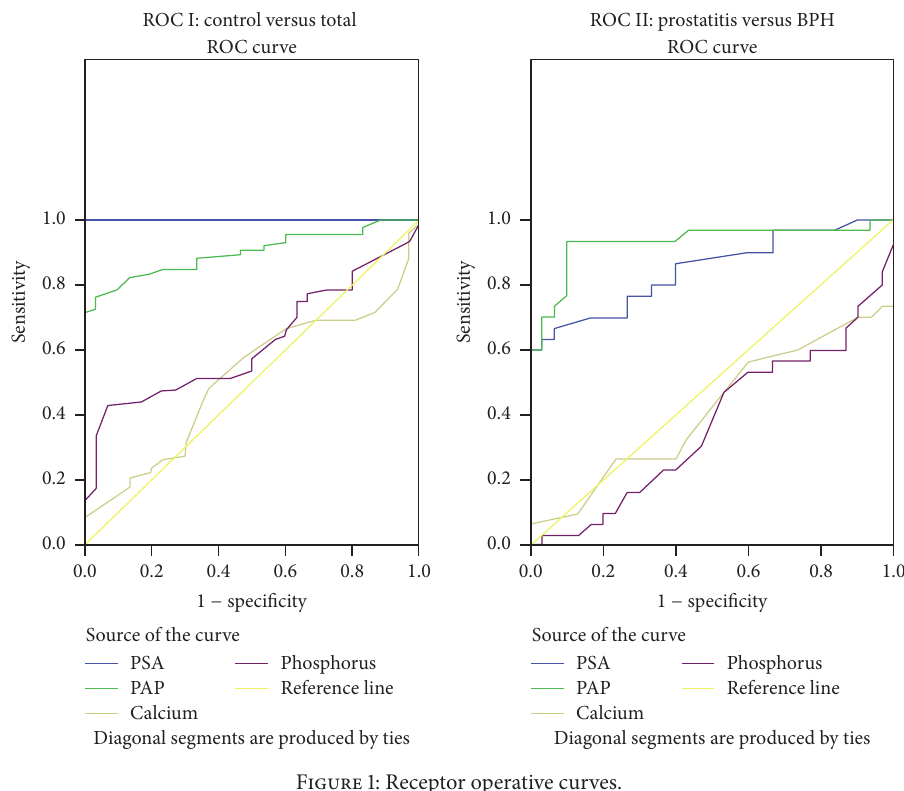
Figure 1: Receptor operative curves.